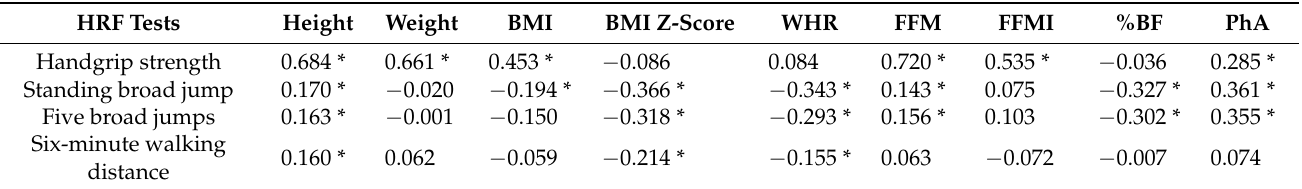
Table 2. Partial correlations (adjusted for sex and age) between health-related physical fitness (HRF) tests and height, weight, BMI, and body composition.